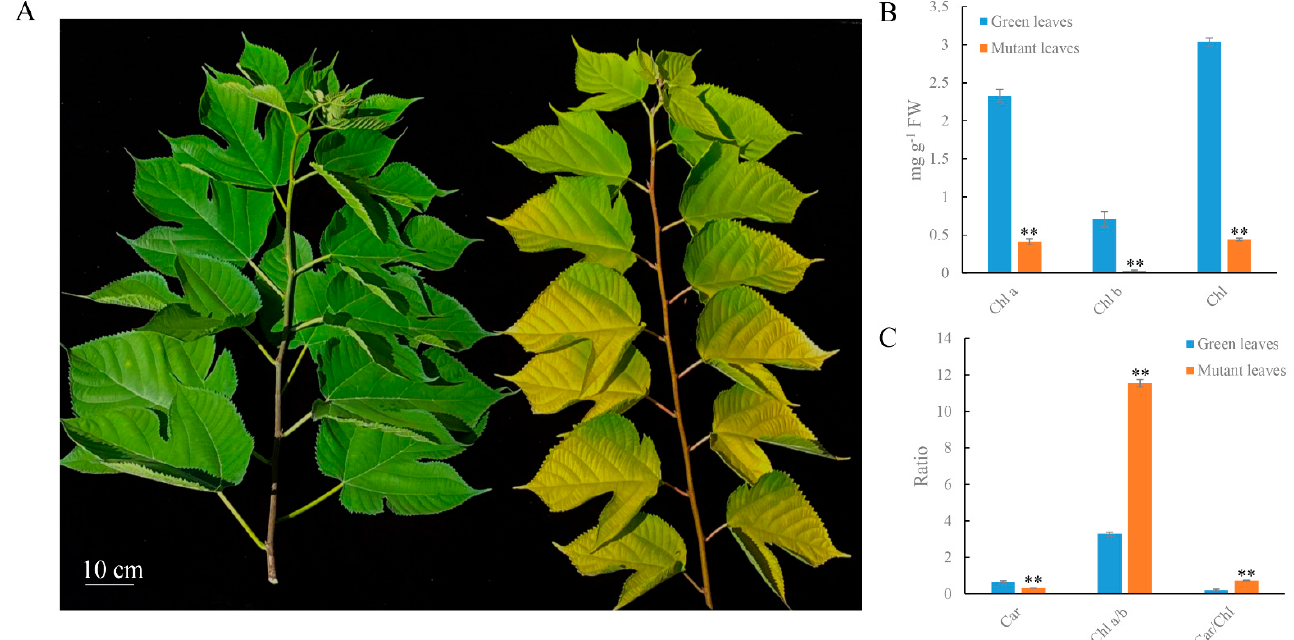
Figure 1. Phenotypic characterization and pigment content (chlorophyll and carotenoid) of green and mutant leaves. ( A ) Phenotypic characterization of green and mutant leaves. ( B ) Chlorophyll (Chl) and carotenoid (Car) content in mg g − 1 fresh weight. ( C ) The ratio of the Chl a to Chl b and Car to Chl. The values shown are mean ± SD from three independent experiments. Significant differences were determined using Student’s t -test in mutant and green leaves (** p < 0.01). Bar = 10 cm ( A ).